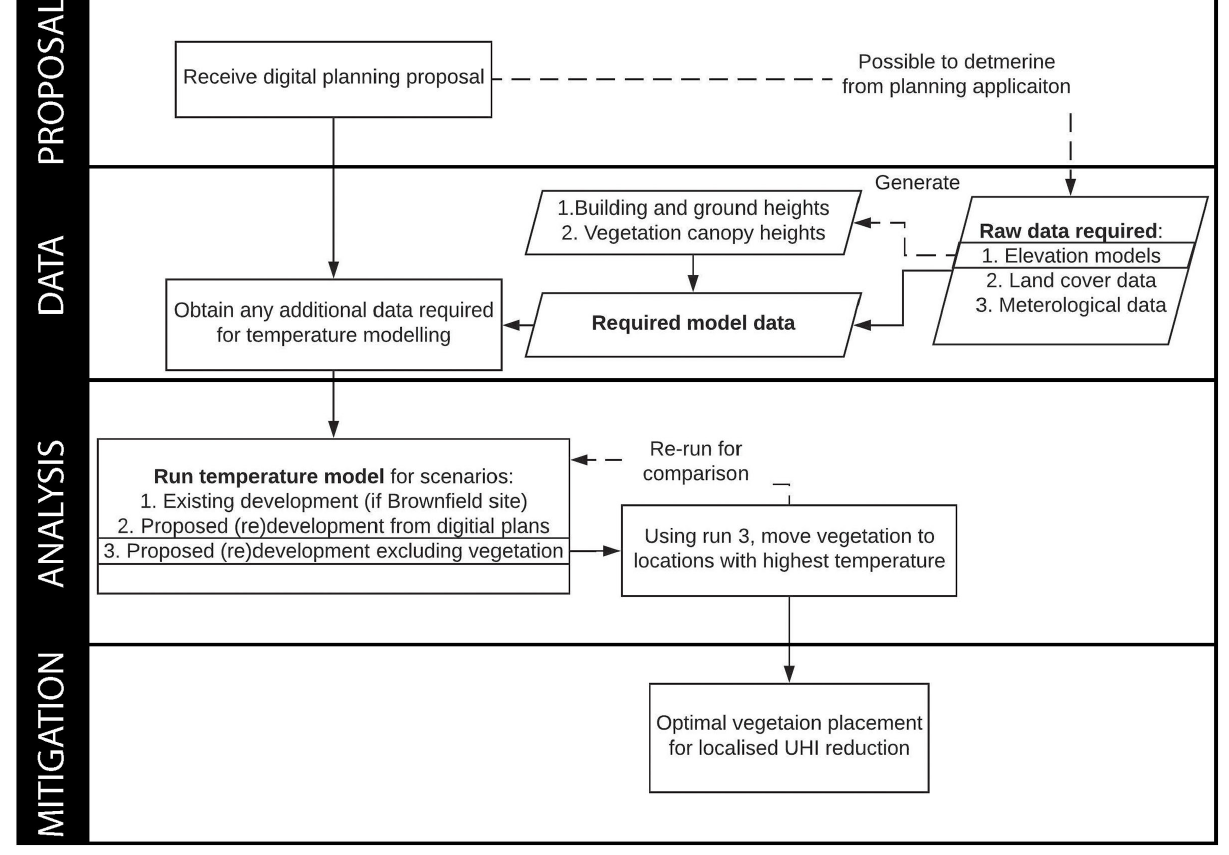
Frontiers in Built Environment |